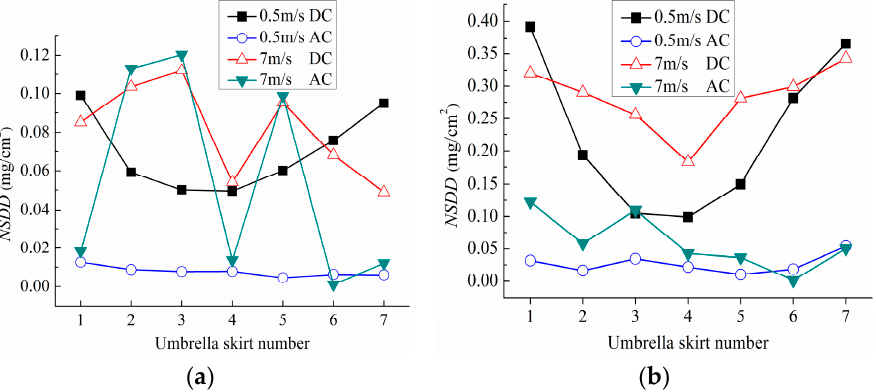
Figure 10. Distribution law of the contamination along the porcelain three-umbrella insulator skirt,